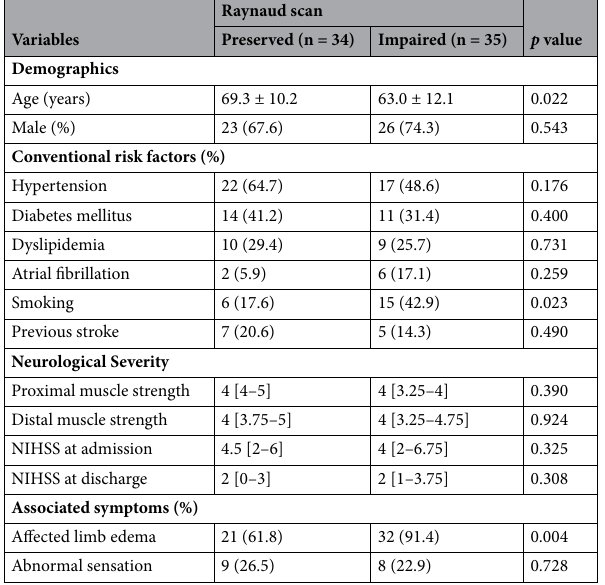
Table 1. Baseline characteristics of study population. NIHSS National Institutes of Health Stroke